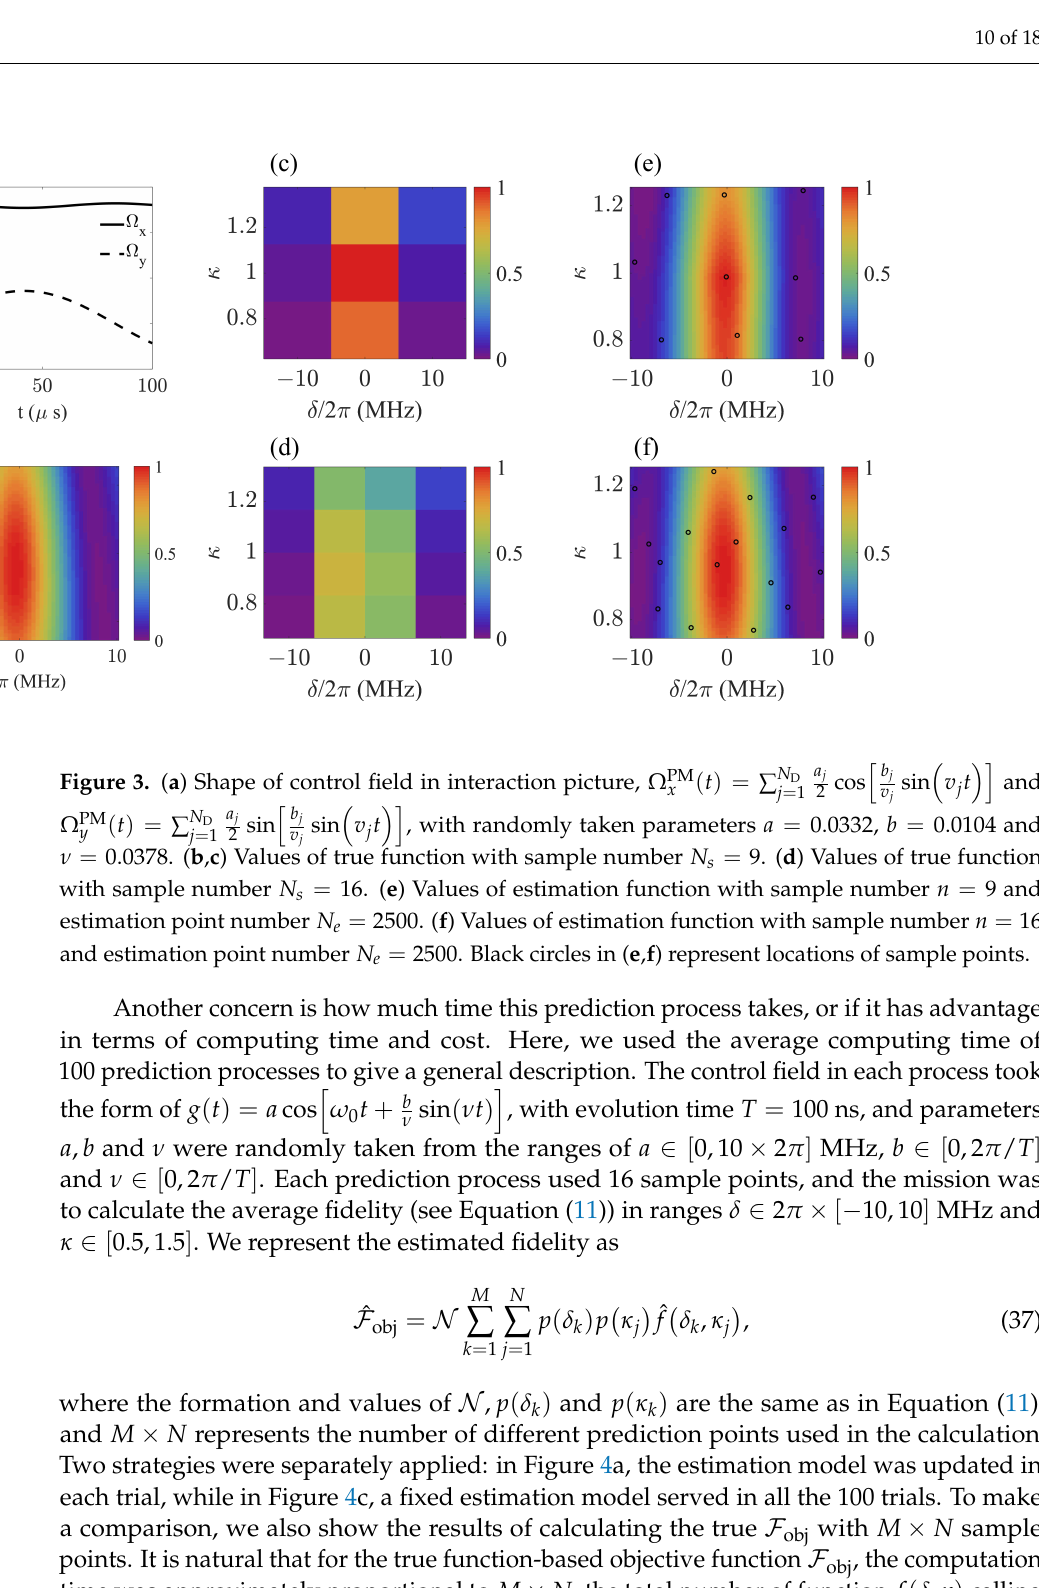
(cid:104) b (cid:16) (cid:17)(cid:105) a j j v j t cos sin and v j 2 j = 1